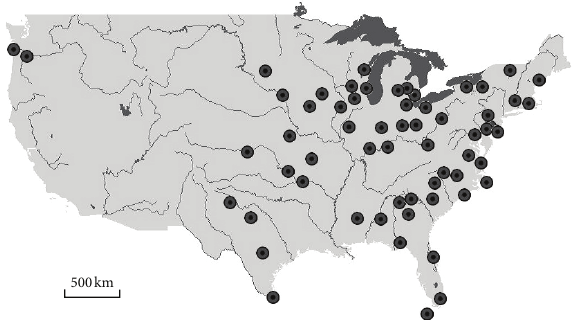
Figure 1: Location of the 61 meteorological stations which provided the data used in the study. These stations have complete data series for the period of